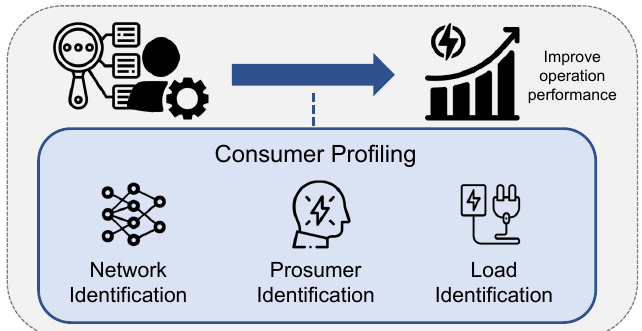
Figure 11. Consumer